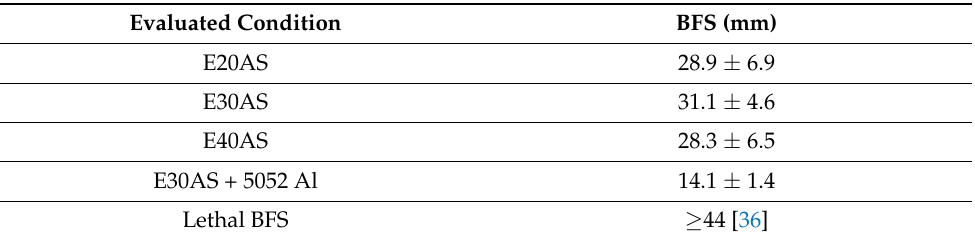
Table 9. Backface signature (BFS) depth of indentation of epoxy composites reinforced with arapaima fish scales tested as MAS second layer against 7.62 mm ammunition.